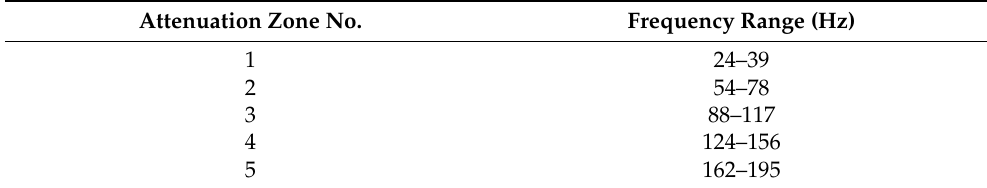
Table 2. Presentation of the first five (analytically calculated) band gaps of the meta-material layout, within the desirable frequency range.